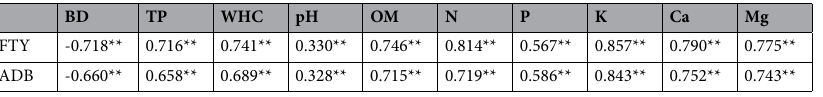
Table 4. Correlation coefficient between yield parameters of cassava and soil properties. *Significant difference at p = 0.05. **Significant difference at p = 0.01.